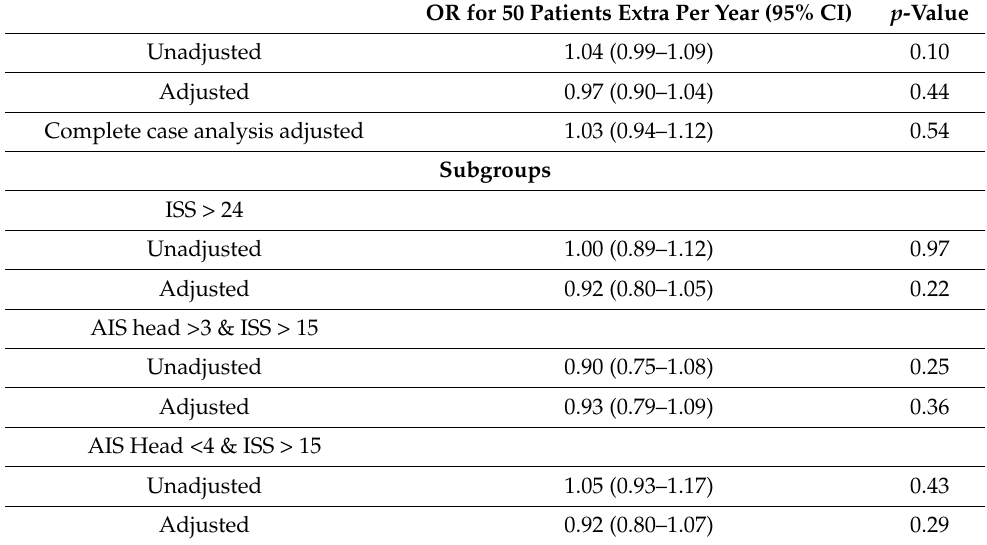
Table 3. Effect of hospital volume on in-hospital mortality.